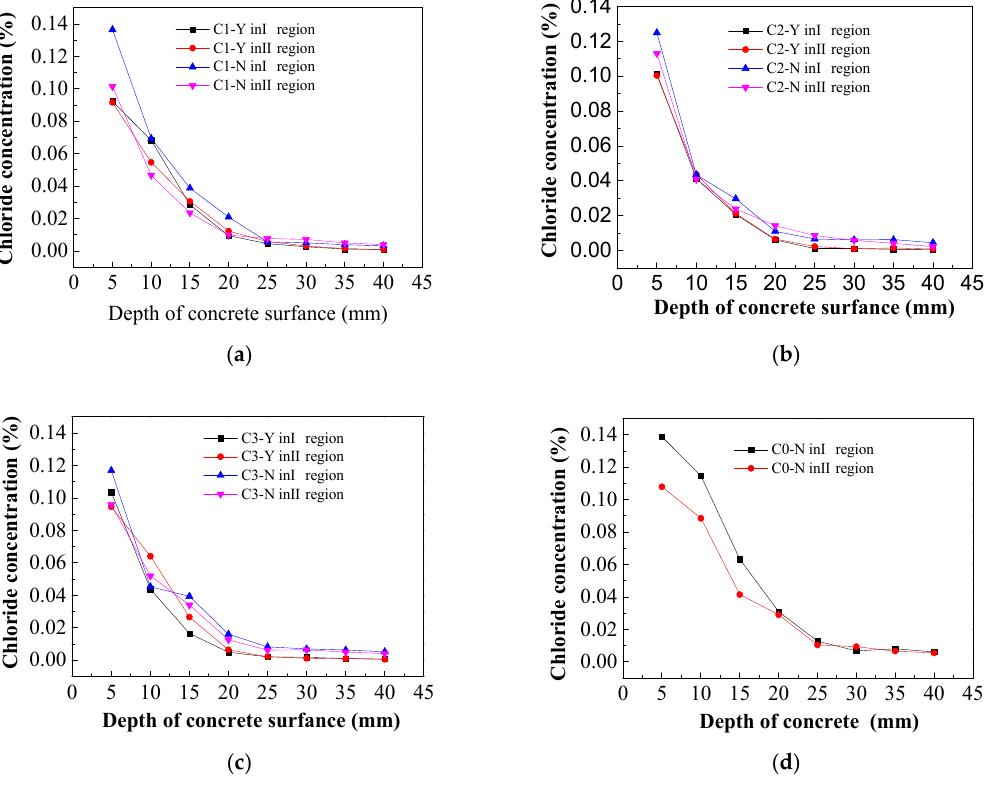
Figure 15. Chloride concentration. ( a ) 0.25% imidazoline inhibitor; ( b ) 0.5% imidazoline inhibitor; ( c ) 0.75% imidazoline inhibitor; ( d ) Control samples.